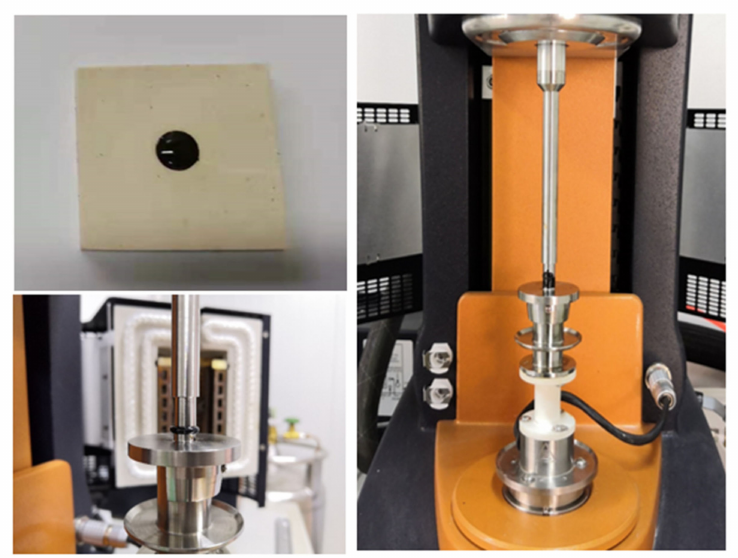
Figure 2. Fatigue test sample and